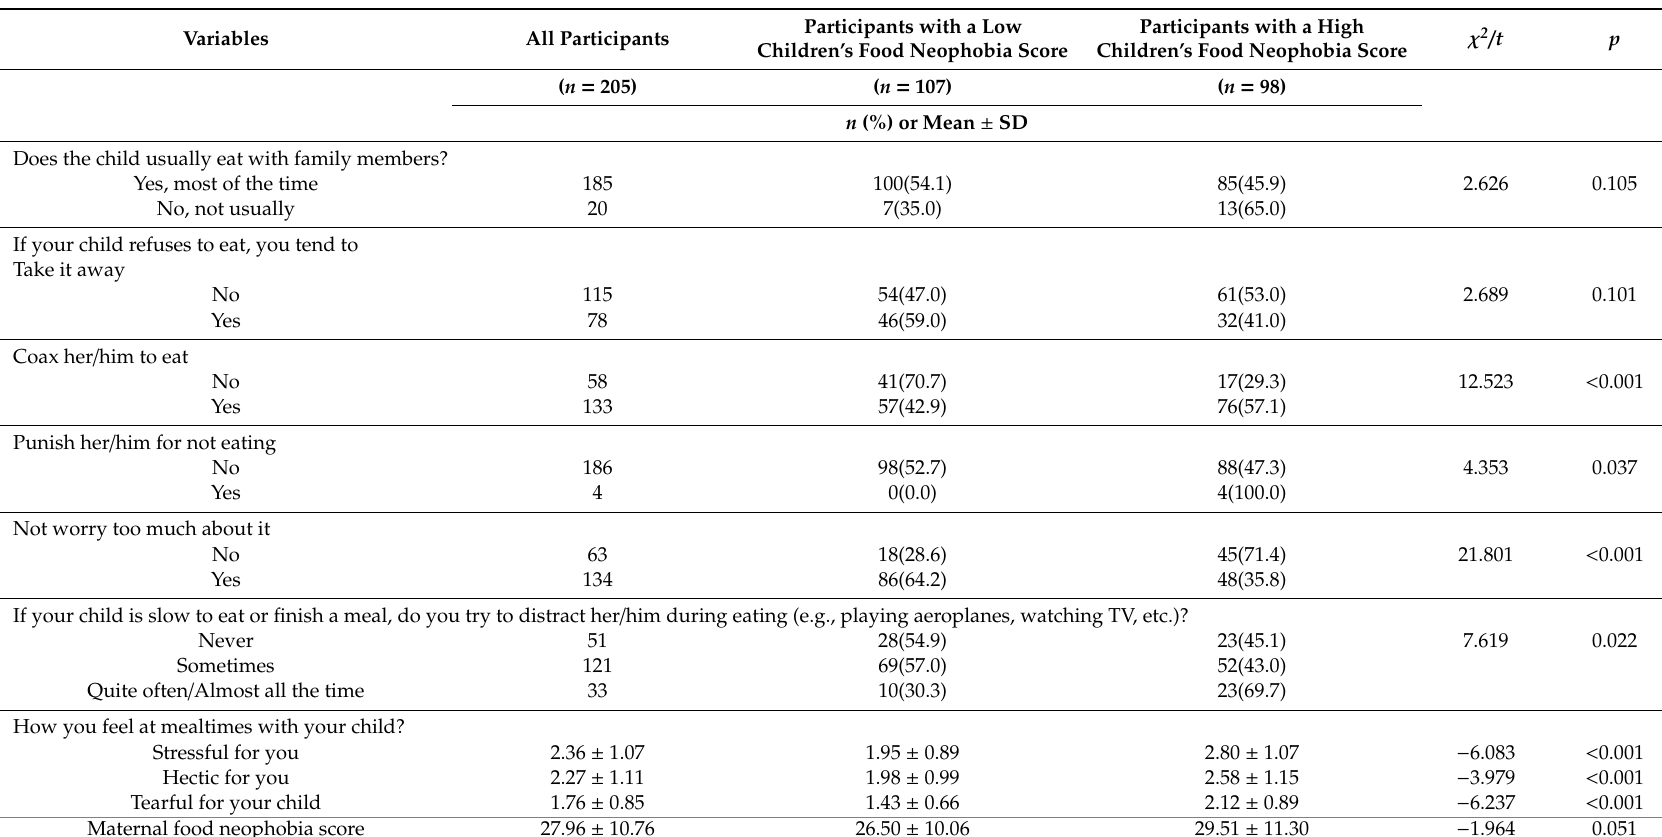
Table 3. Maternal toddler feeding factors, classified by participants with low and high children’s food neophobia scores.